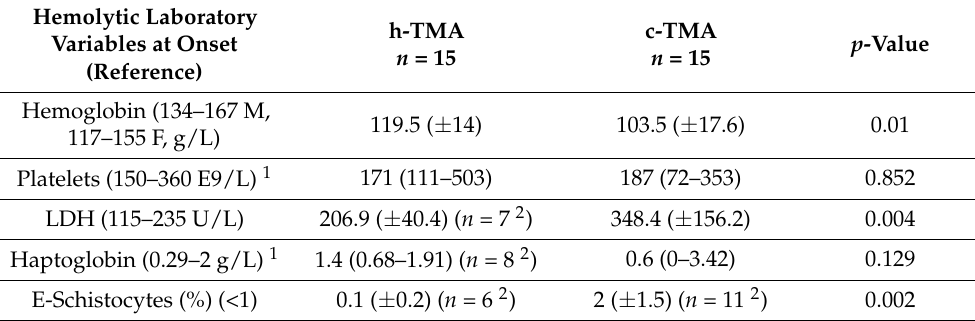
Table 3. Hemolytic variables at the time of diagnosis. Reference values and units are shown in parenthesis. Values are expressed as means ( ± SD), or medians (range). p -value shows the comparisons between histological TMA (h-TMA) and clinical TMA (c-TMA)